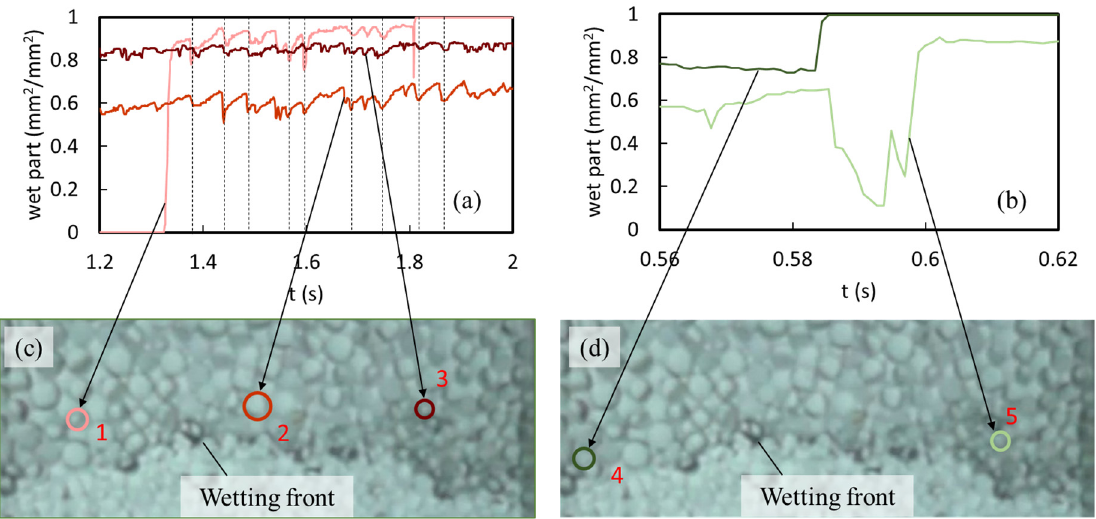
Figure 9. The time series and the percentage of the wet part of each bead. ( a , c ) indicated that the oscillations of the wetting front synchronized with each other. The dashed line expresses the time when backward infiltration was observed. ( b , d ) indicated that the wetting front on bead number 5 went backward when the wetting front on bead number 4 went forward. The wetting front on bead number 5 infiltrated forward more after the front moved backward, which suggested that inertia forces played an important role in the wetting process.